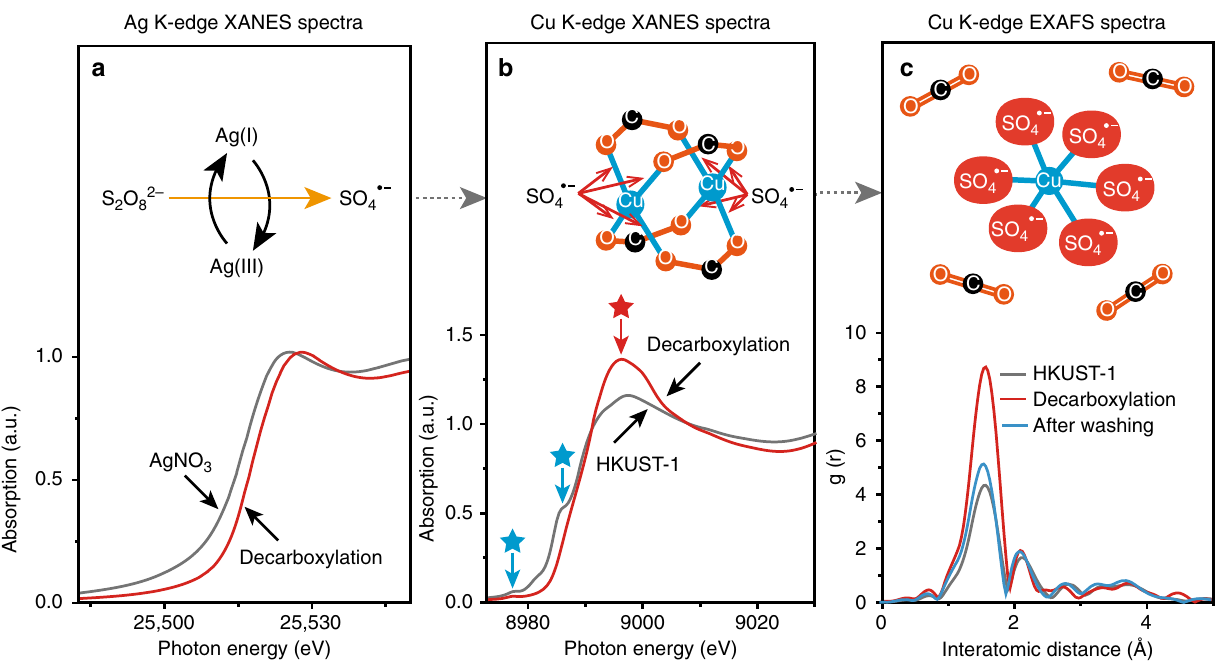
Fig. 3 XANES and EXAFS spectra measured during decarboxylation at 120 °C. a Change in Ag K-edge XANES spectra for AgNO 3 and b change in Cu K- edge XANES spectra, c change in Cu K-edge EXAFS spectra before and after the decarboxylation and after washing